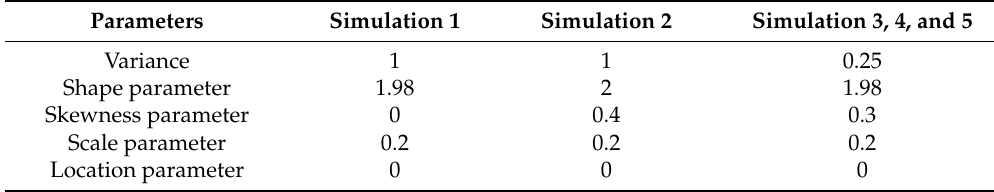
Table 2. Parameters of alpha stable